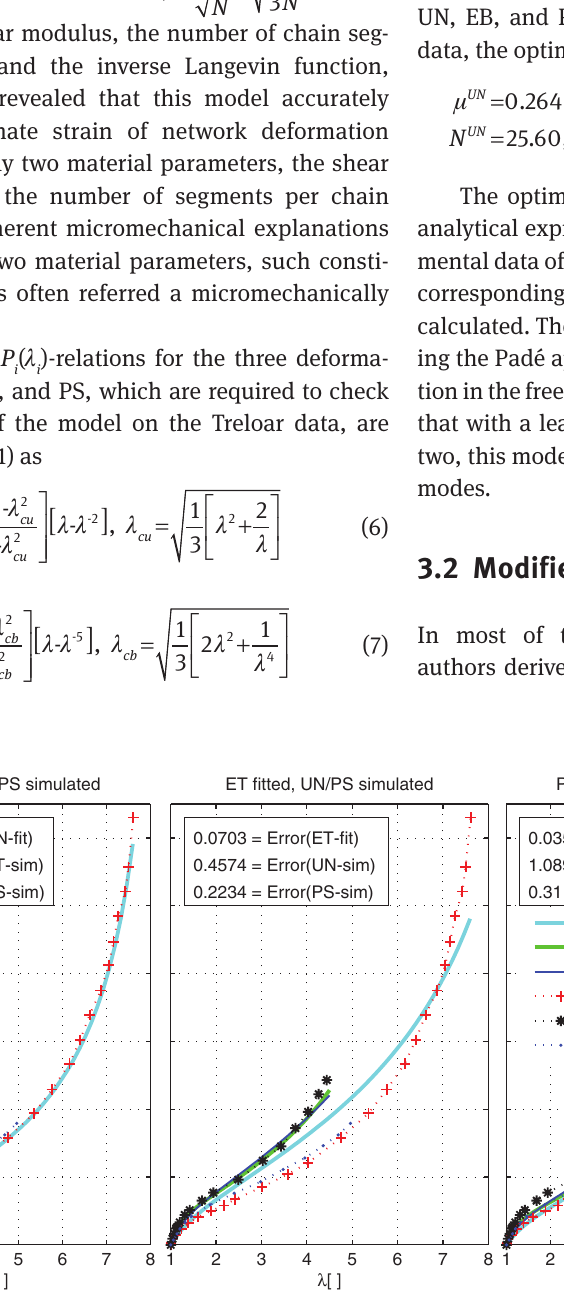
Figure 2: Performance of the eight-chain model on the Treloar data. The fittings and simulations in two deformation modes (UN and EB) are good to excellent except in the pure shear case where the prediction fails to reproduce the S-shape of uniaxial case at high strains. Uniaxial simulation and fitting are almost concident (left), whereas equibiaxial simulation overestimates the Treloar